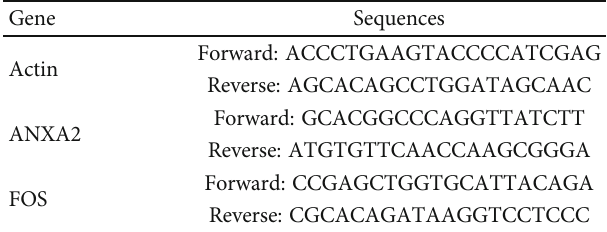
Figure 8: The fl owchart designed for the study. Table 1: Real-time primer sequences of HK-2 cell line primer